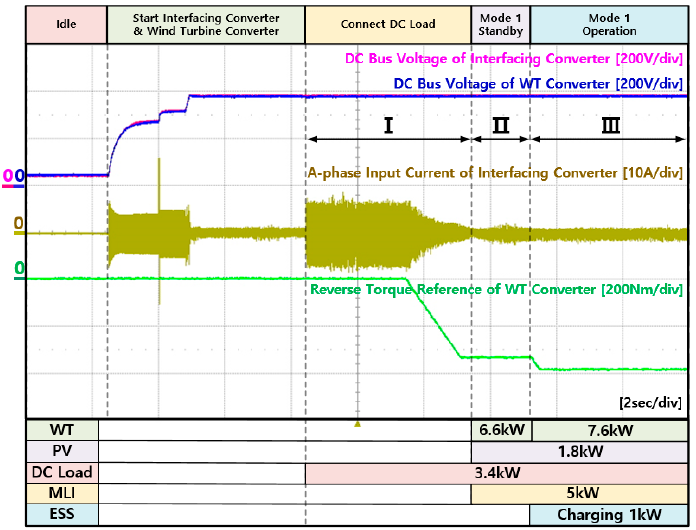
Figure 11. Experiment waveforms of interfacing converter and WT converter in mode